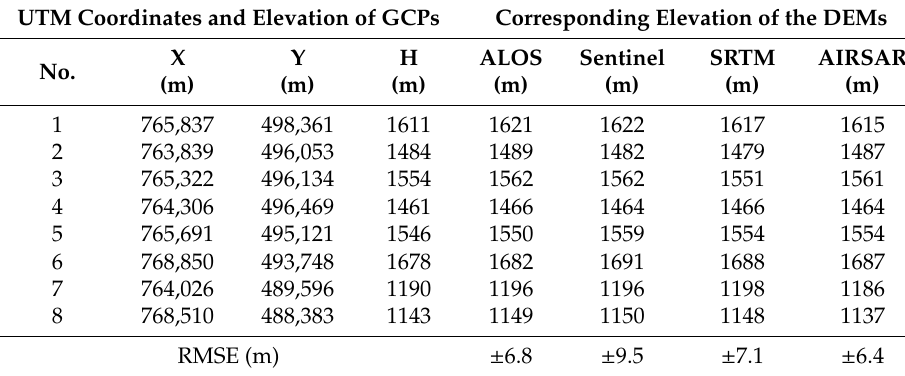
Table 5. Validation of the DEMs using GCPs